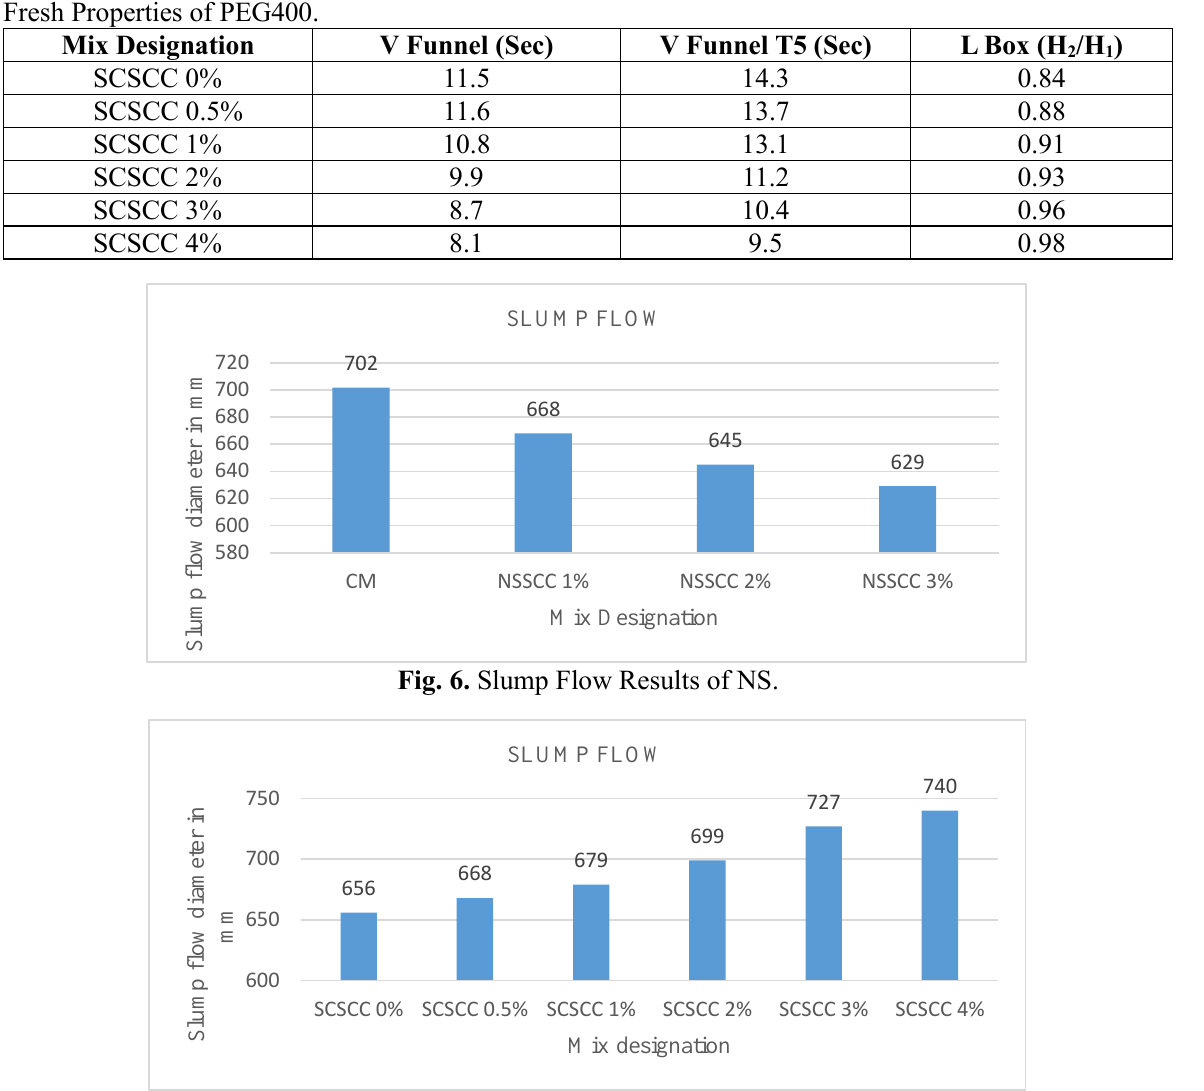
Fig. 6. Slump Flow Results of NS.